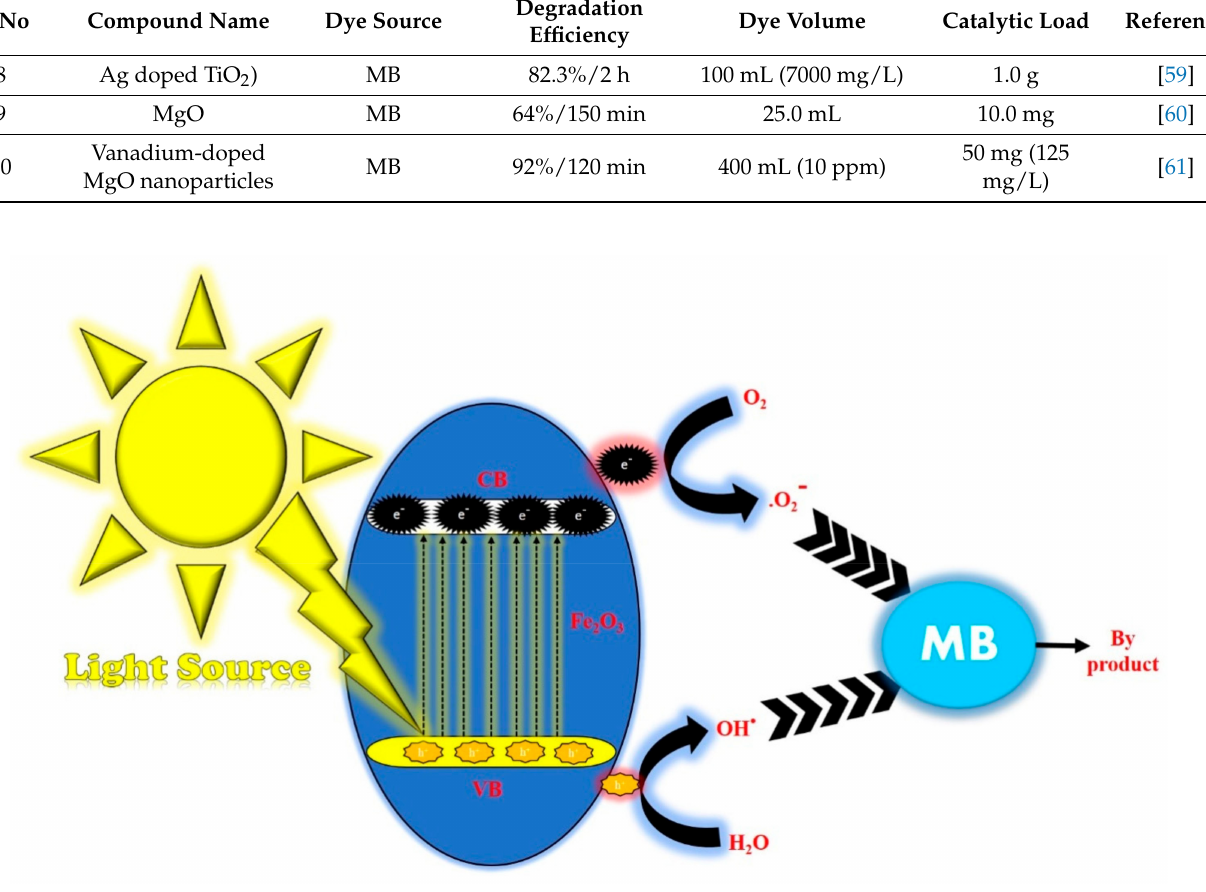
Figure 11. Photocatalytic degradation mechanism of FNH